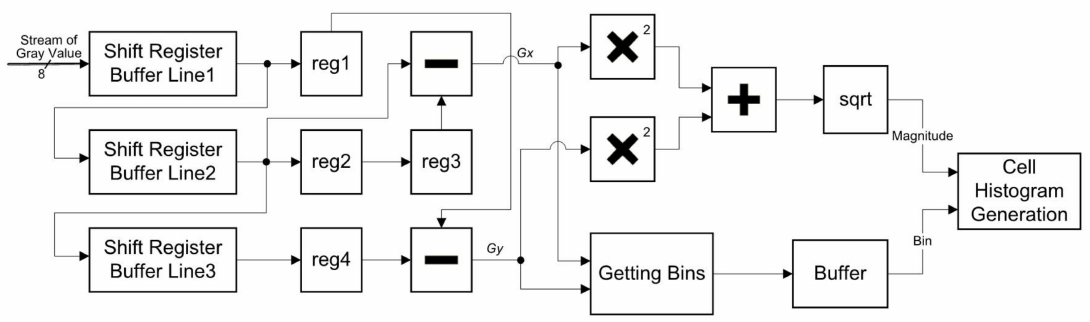
Figure 3. Diagram of the Gradient Calculation sub-module in the proposed